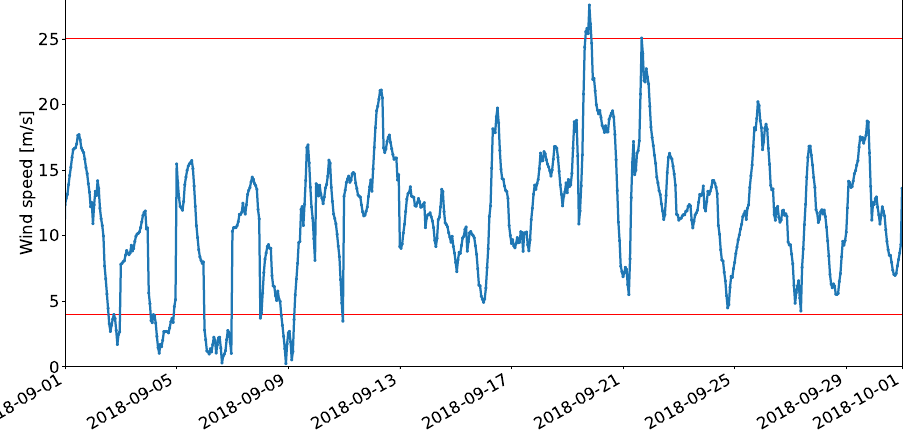
Figure 10. ERA5 wind speed at 100 m at Hywind Tampen in September 2018. The cut-in and cut-out wind speeds of the DTU 10MW turbine are marked with red